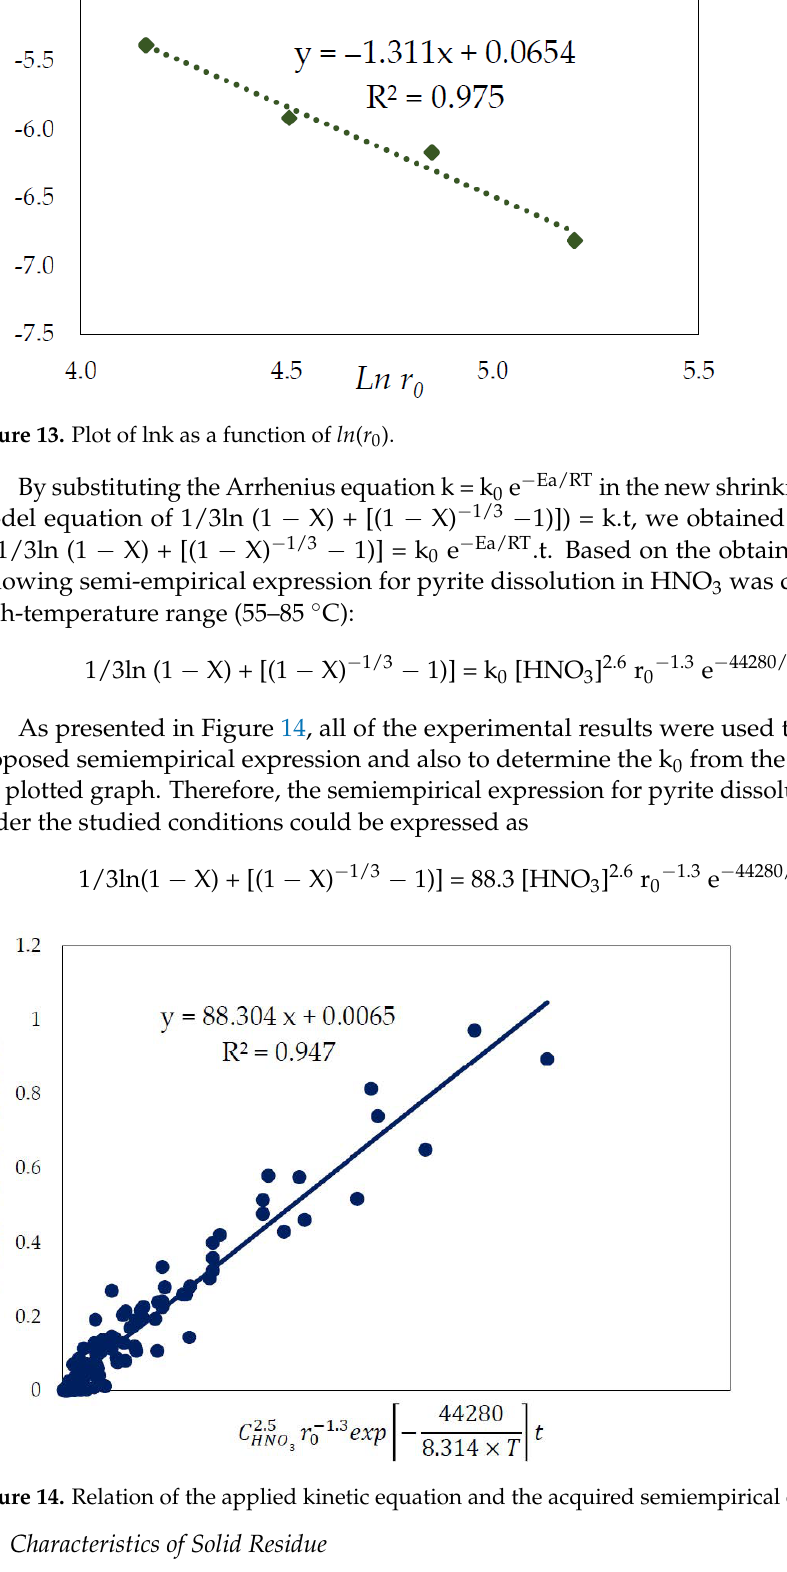
Figure 14. Relation of the applied kinetic equation and the acquired semiempirical expression .